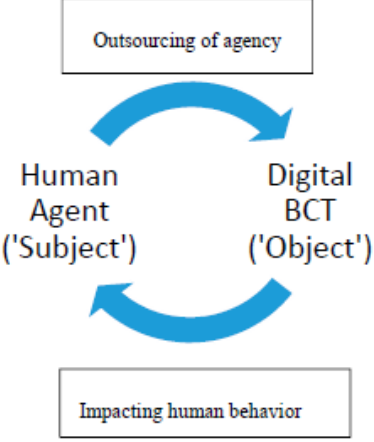
Figure 1. Agency and digital objects.